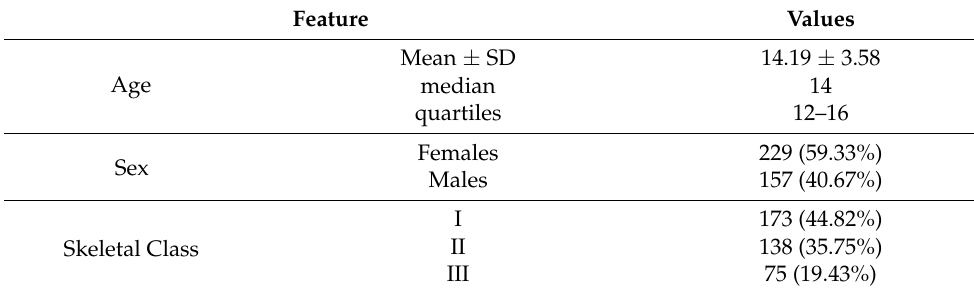
Table 3. Characteristics of the study group (n = 386).